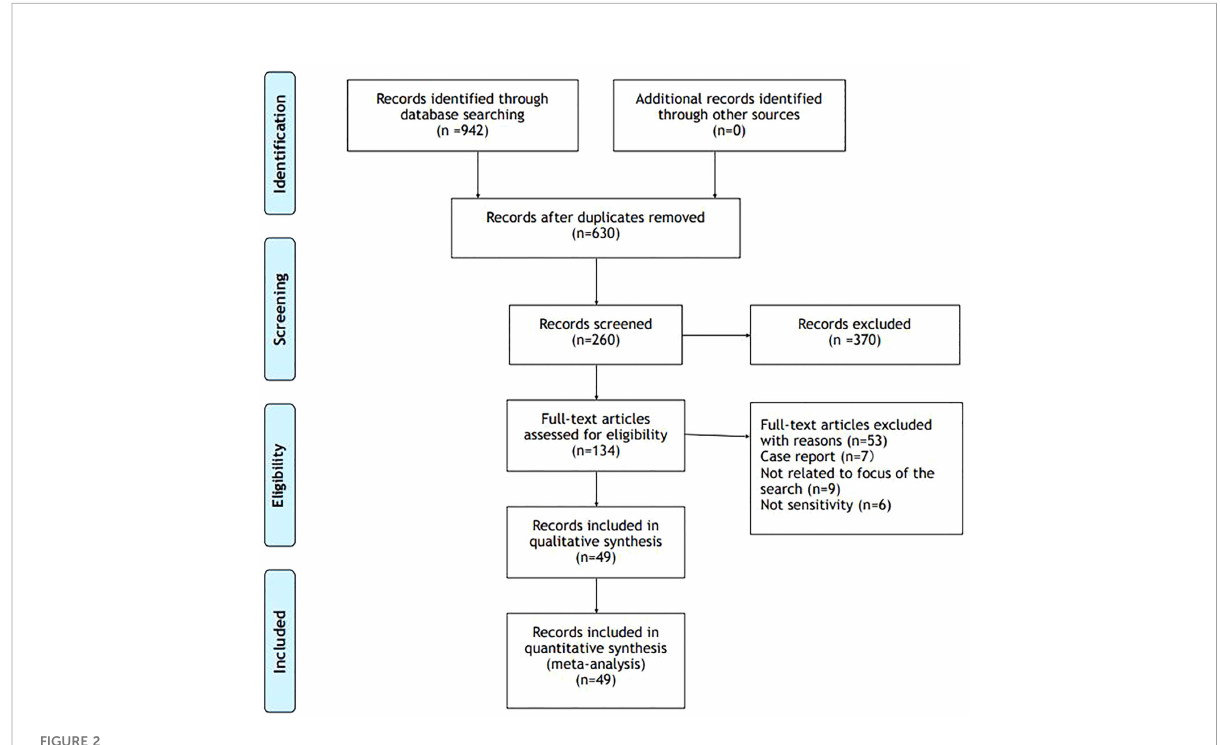
FIGURE 2 PRISMA Flow